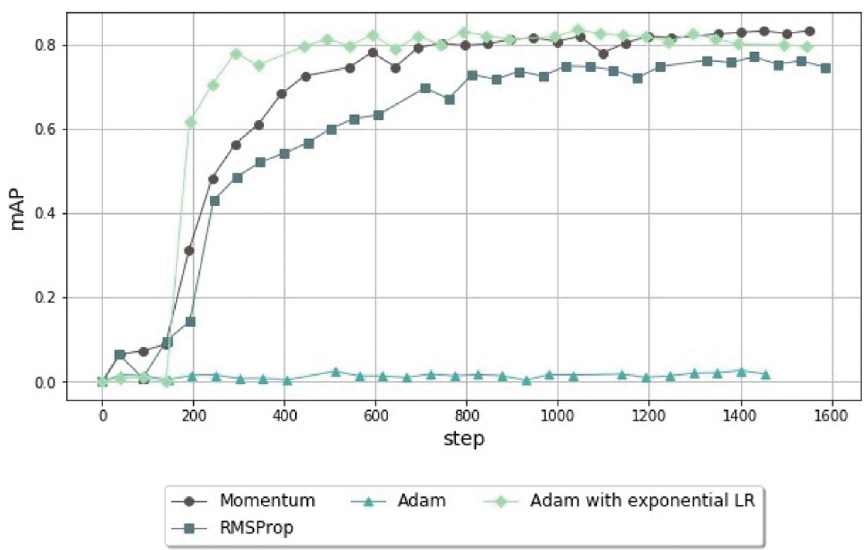
Fig 7. Comparison of mAP performance of the object-detection models trained using different optimizers (Momentum, Adam, Adam with exponential learning rate, and RMSProp) for 1,400 steps. Adam, which is known for achieving a faster convergence than the remaining optimizers, cannot achieve a satisfying performance if the learning rate decay is not well adjusted.